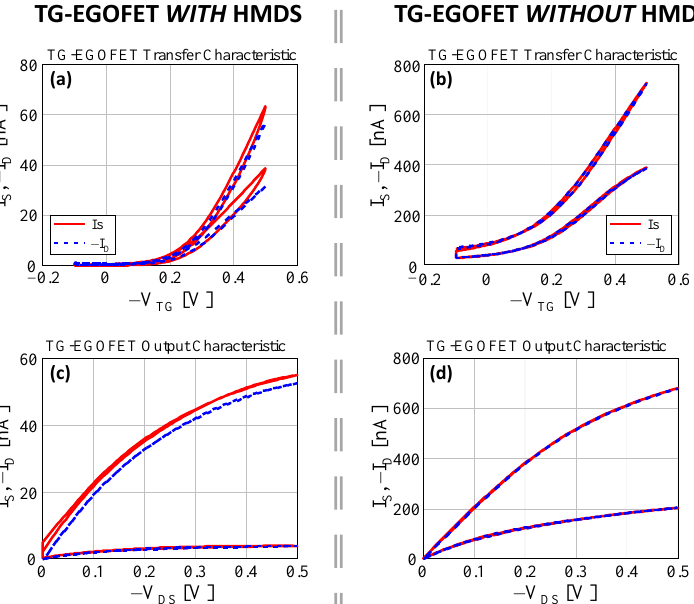
Figure 4. TG-EGOFETs characterizations with and without HMDS functionalization: ( a ) Transfer characteristics with HMDS; ( b ) transfer characteristics without HMDS; ( c ) output characteristics with HMDS; ( d ) output characteristics without HMDS. Discrepancies between the source (I S ) and drain (I D ) currents are due to the TG leakage current (see Supplementary Figure S4).